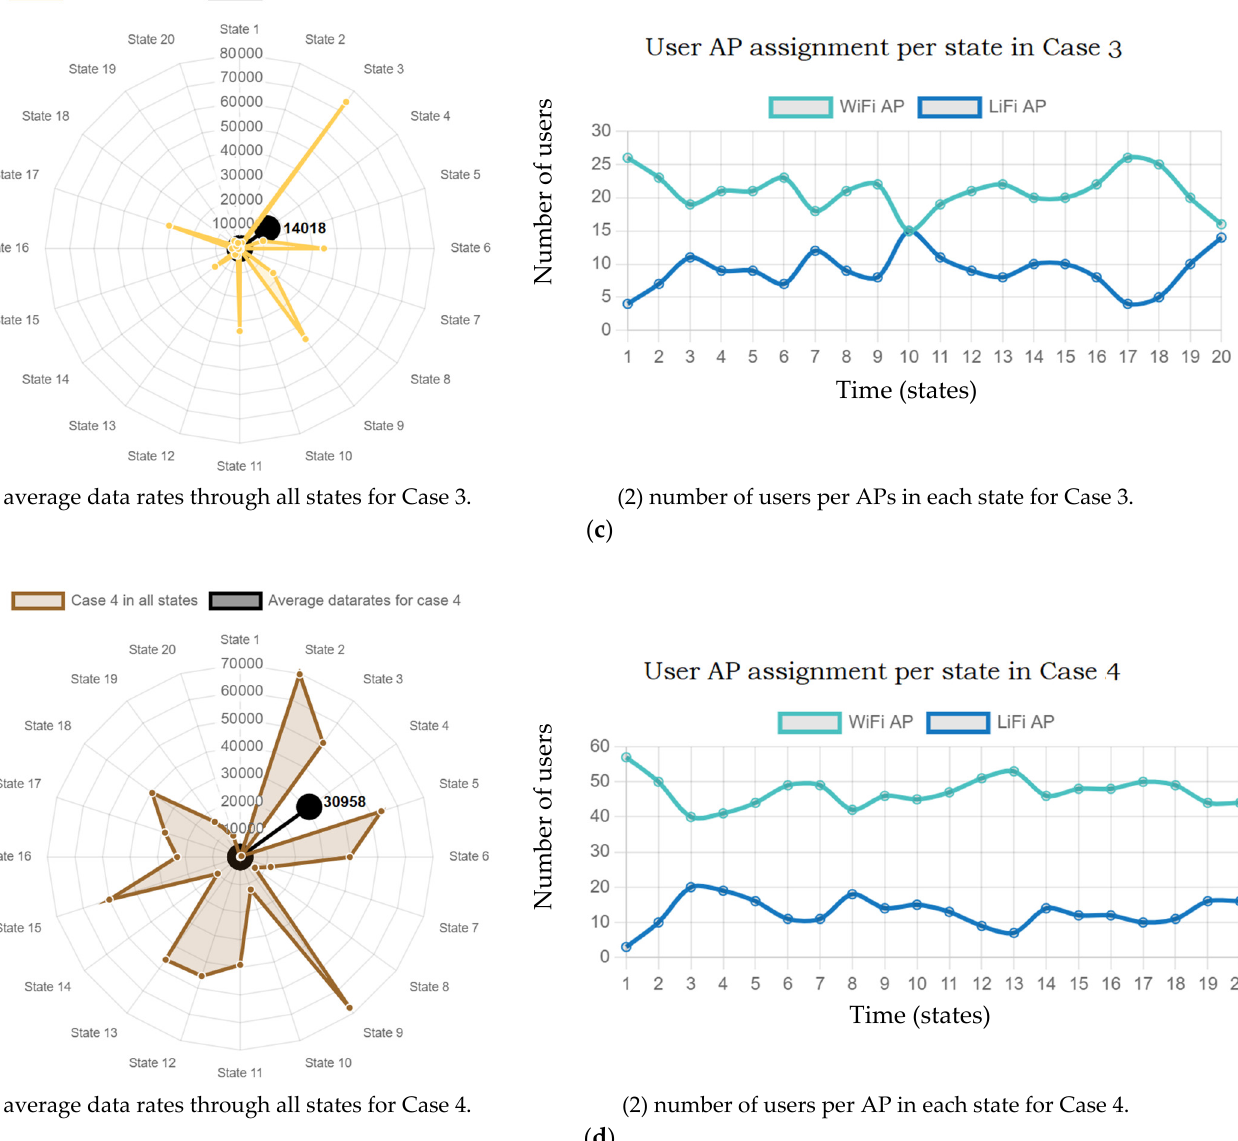
Figure 12. Theoretical results of average data rates patterns, user density, and user assignment per AP. ( a ) Case 1, ( b ) Case 2, ( c ) Case 3, and ( d ) Case 4.